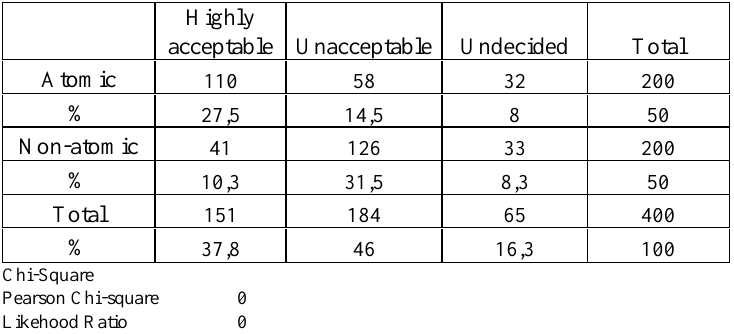
Table II: Crosstab between atomic/non-atomic vs. judgment of the first experiment